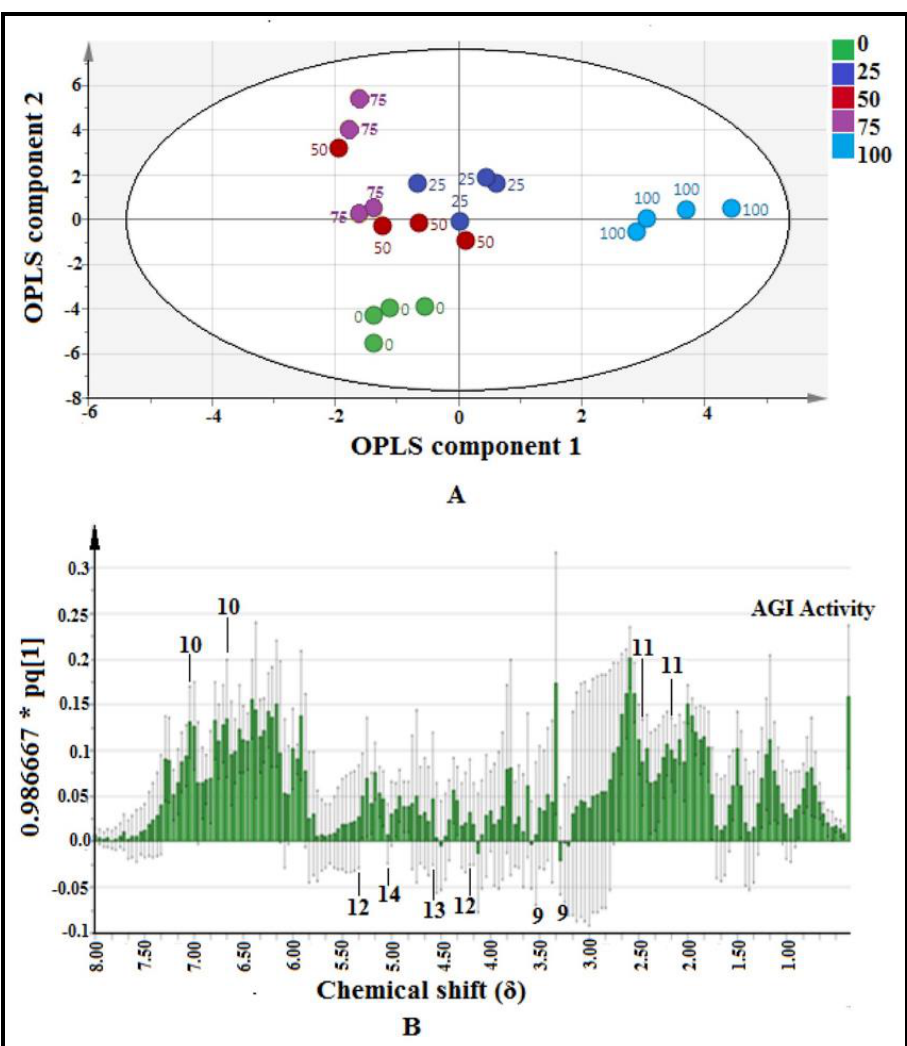
Figure 6. ( A ) Score scatter plot of validated OPLS model for 20 extracts of P. malayana leaves ( n = 4), indicating the clear separation among the five groups (0, 25, 50, 75, and 100% v / v methanol-water). ( B ) The loading column plot of OPLS model, indicating the correlation between AGI activity (Y variables) and the samples’ δ value (X variables).